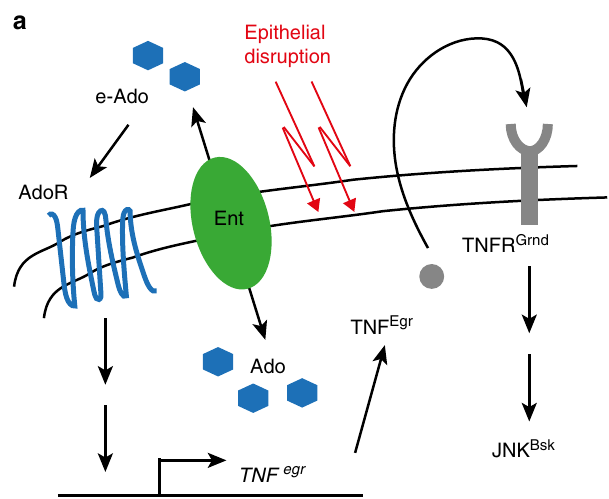
Fig. 5 Summary model of AdoR signalling in polarity de fi cient discs. Polarity stress triggers the release of adenosine in the extracellular space. Subsequent activation of AdoR signalling leads to the production of TNF, which in turn activates